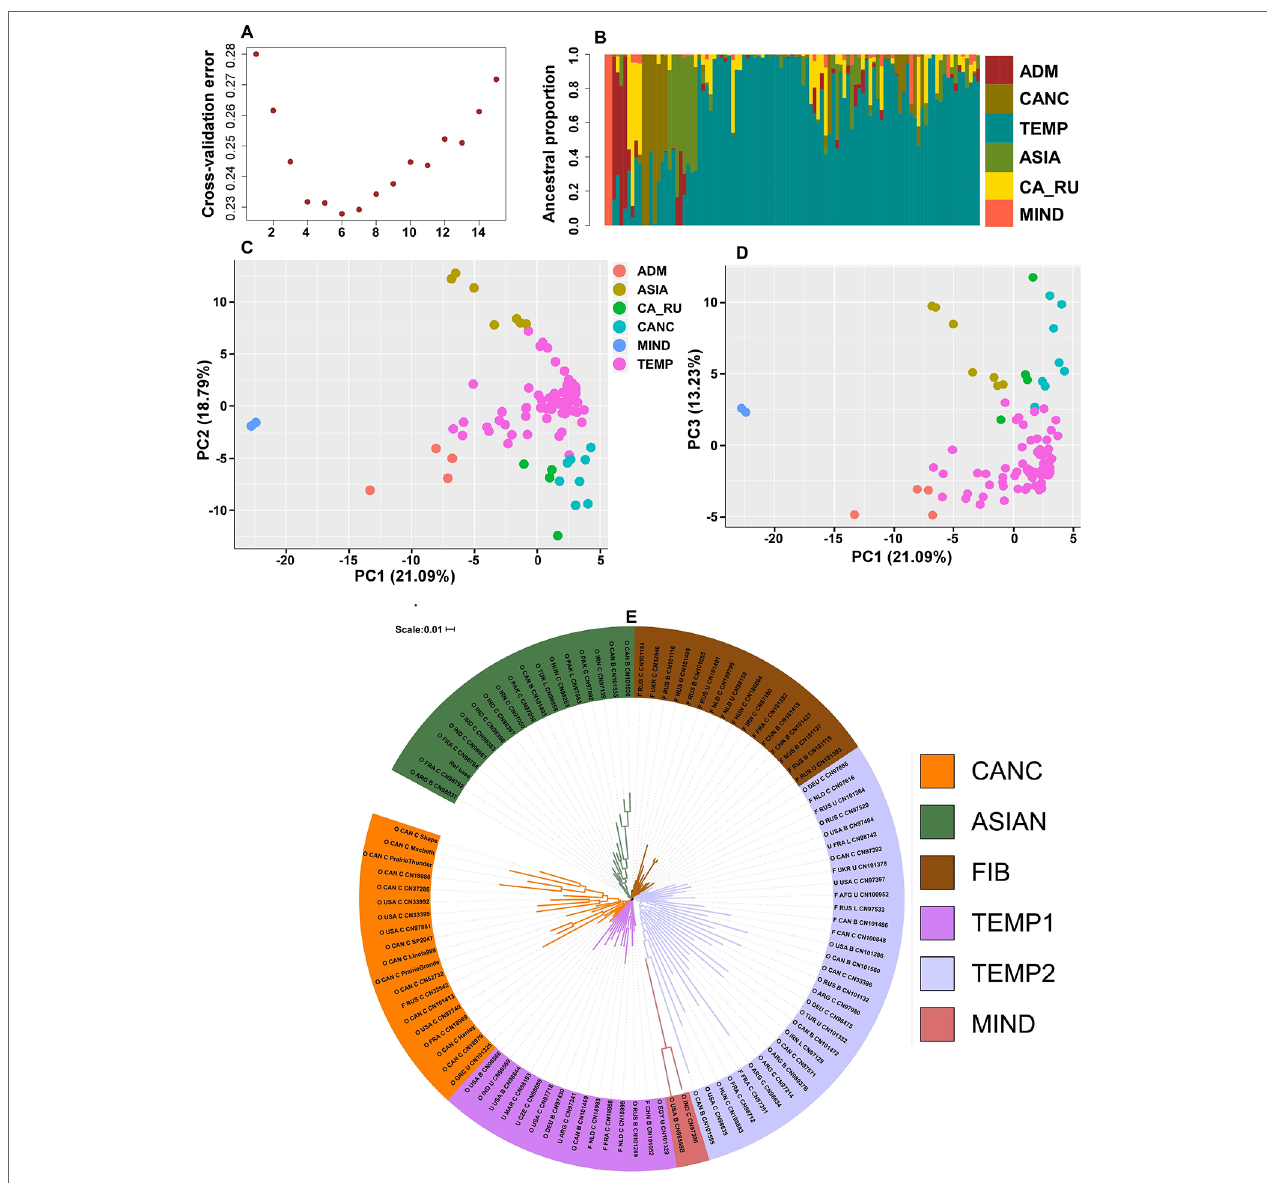
FIGURE 3 | Population structure. (A) Estimate of the number of ancestral populations indicating six as the best fit, (B) population structure plot showing the six populations in different colors, (C) principal component analysis (PCA) plot of the first two principal components (PCs) where the percentages in parentheses represent the variance explained by the PCs, (D) PCA plot of the first and third PCs, (E) neighbor-joining (NJ) dendrogram where naming convention indicates the type (O, oil; F, fiber; U, unknown), the country of origin, the breeding status (C, cultivar; B, breeding material; L, landrace) followed by the accession name.